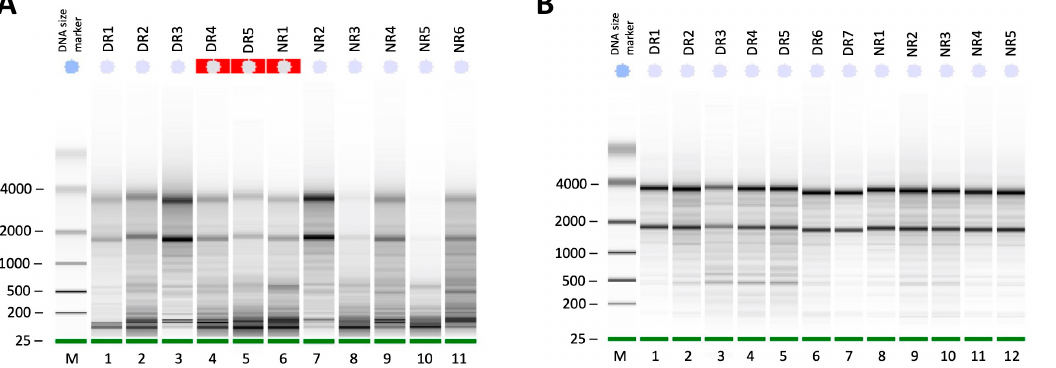
Figure 5. Virtual gel-like images generated by an Agilent 2100 Bioanalyzer using the pico and nano kits. ( A ) There was a high level of RNA degradation in samples extracted using the standard RNeasy mini protocol (Qiagen). Samples isolated from diabetic rats (DR) are presented in lanes 1–3, which had an RIN range from 4.2–7, while those from normal rats (NR) in lanes 7–11 had an RIN value between 2.3–7.3. Red highlighted lanes 4–6 show samples with low RIN values that could not be calculated due to degradation or sample contamination. ( B ) Intact RNA with very low levels of degradation in samples extracted using our optimized method. Samples isolated from diabetic rats (DR) are presented in lanes 1–7, which had an RIN value range from 6.7–8.8, while those from normal rats (NR) in lanes 8–12 had an RIN value ≥ 8.0 except for NR2 and NR3 (RIN = 7.4, 7.2), which was due to a technical difficulty during the homogenization